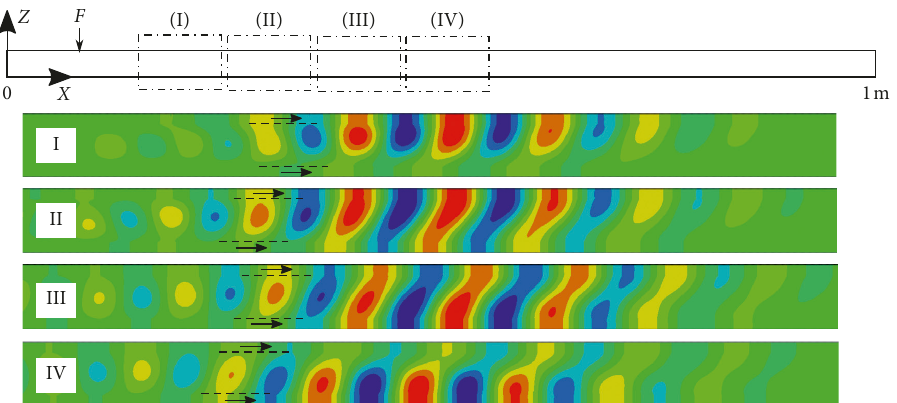
Figure 4: Wave pattern at the excitation frequency 75kHz in different regions of the plate for (I) t � 0.09ms, (II) t � 0.15ms, (III) t � 0.21ms, and (IV) t � 0.27ms. The dotted lines show the approximate location of the laminate skins, and the arrows show the direction of propagation.